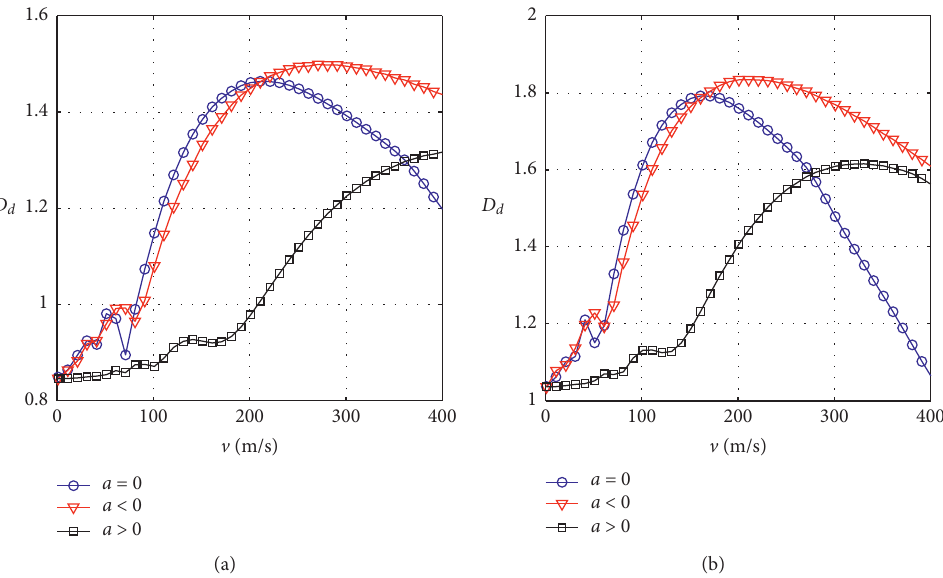
Figure 11: Moving load speed versus DMF of (2-1-2) beam under different motions of moving load. (a) n